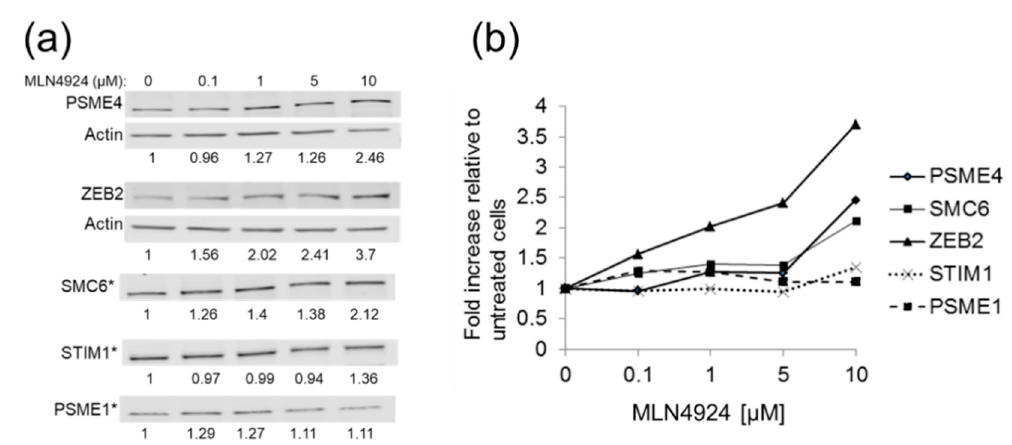
Figure 3. Putative HBV restriction factors are processed through a CRL complex: ( a ) HEK293T cells were cultured for 24 h in the presence of increasing concentrations of the CRL inhibitor MLN4924. Protein levels for putative restriction factors PSME4, Zinc Finger E-Box Binding Homeobox 2 (ZEB2), STIM1, and PSME1 and for SMC6 [13,14] in the absence and presence of MLN4924 were determined by western blot assays and normalized either to total protein (indicated by asterisks) or to actin (described in the Materials and Methods section). ( b ) Graphical representation of western blot shown in panel ( a ): The level of normalized restriction factor in untreated cells was set to 1.0 and the levels of the same protein in MLN4924-treated cells compared to that. PSME4, ZEB2, and SMC6 showed increasing levels with increasing amounts of MLN4924, indicating they are normally processed through a CRL. STIM1 levels increased with the highest dose (10 µ g), while PSME1 levels were not impacted by drug treatment. Results shown are representative of n = 3 independent experiments.